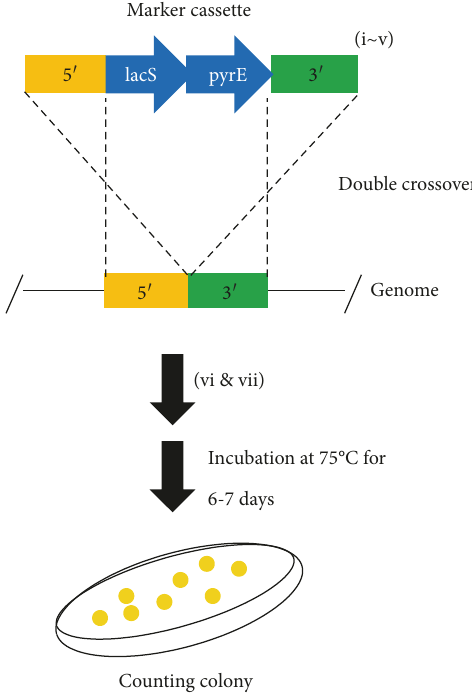
Figure 1: Schematic and optimization of transformation procedure. A marker cassette containing the 5 ′ and 3 ′ homologous regions of the target locus at both ends of pyrE - lacS marker genes was electroporated into strain SK-1 ( Δ pyrE Δ suaI ) under various conditions: (i) DNA topology, (ii) CaCl treatment, (iii) growth 2 phase of competent cells, (iv) DNA volume, and (v) length of fl anking region. After electroporation, cells were cultivated in recovery bu ff er (vi) as needed and plated onto XT plates by spreading or overlay plating (vii). The resulting colonies were de fi ned as transformants and